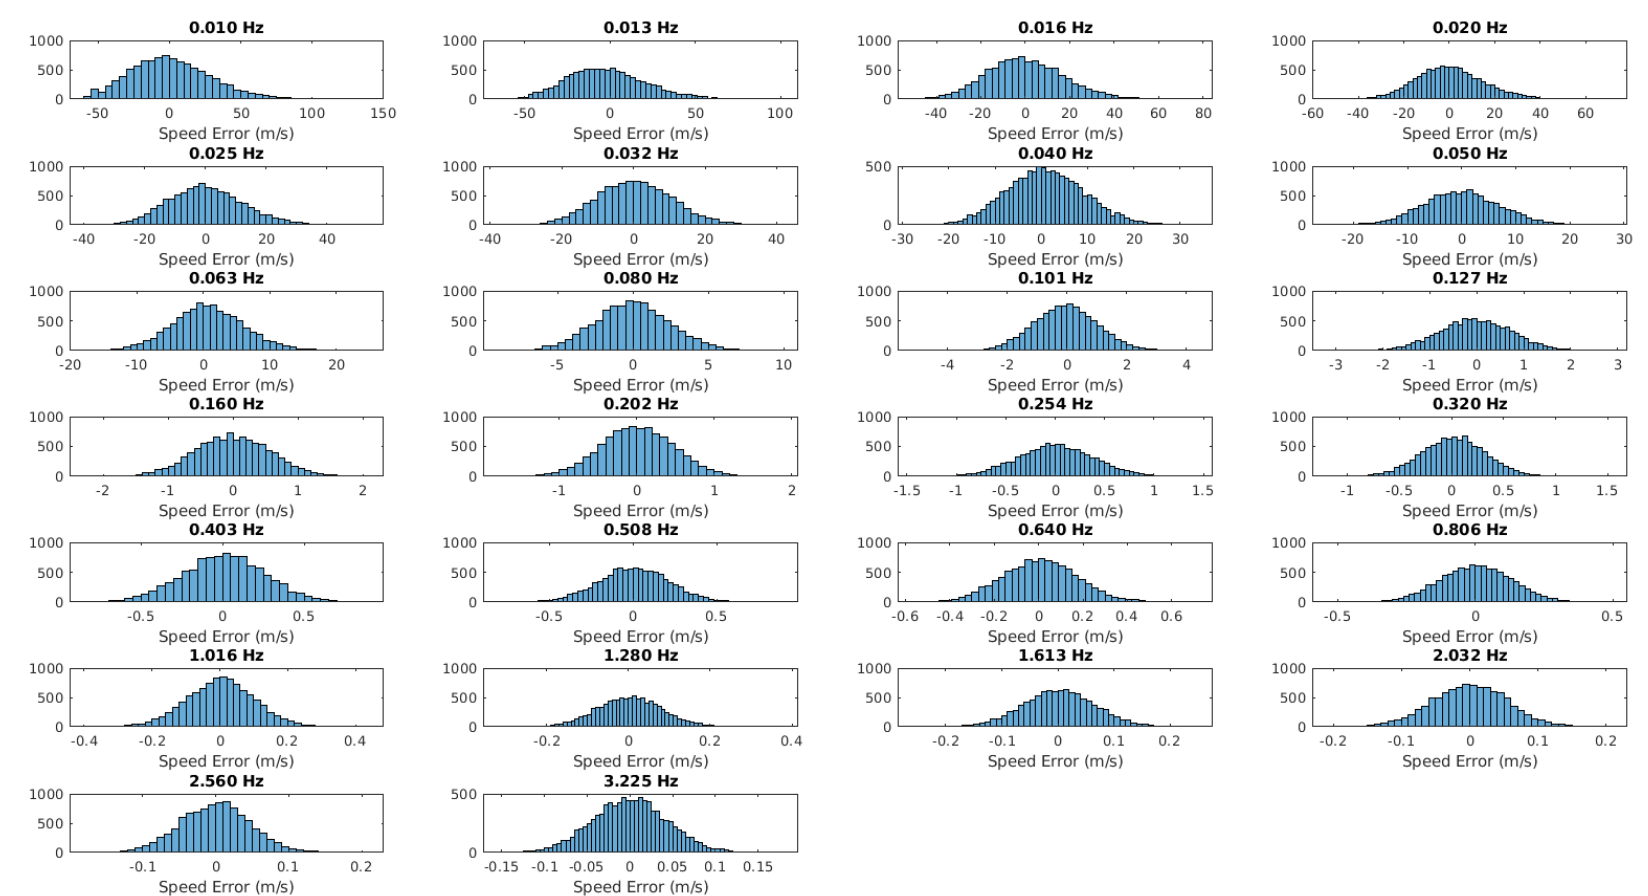
Figure A2. Trace velocity error (bias), SNR = Inf, M = 10 4